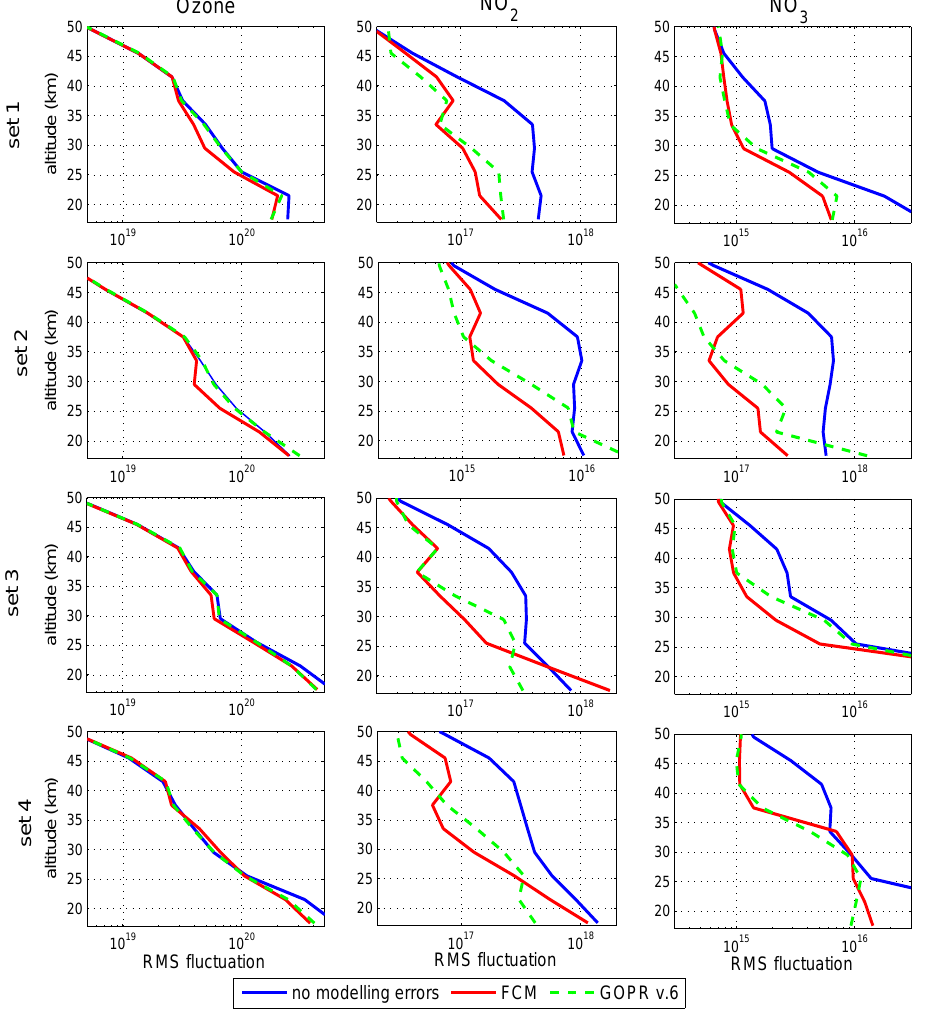
Fig. 3. Rms of horizontal column density fluctuations for different processing methods. Left column: ozone, middle column: NO 2 , right column: NO 3 . The rows correspond to the data sets (Table 1), which are indicated in the figure.